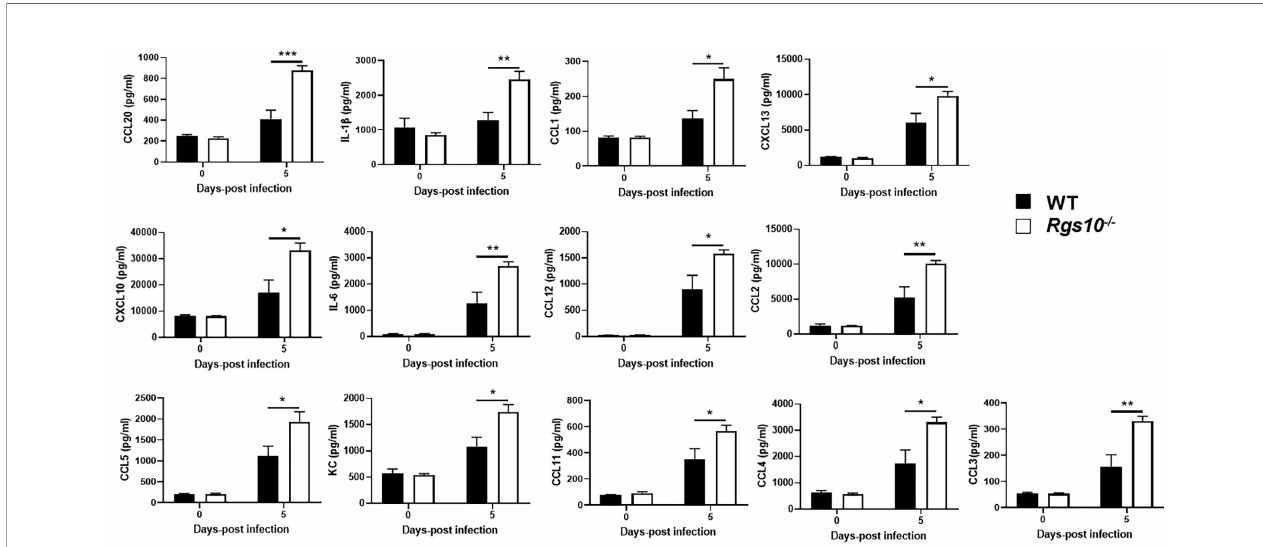
FIGURE 4 | Rgs10 de fi ciency elevates cytokine and chemokine levels upon IAV infection. The bead-based Bio-Plex assay was used to measure cytokine and chemokine levels in the BALF supernatants of uninfected (0 dpi) WT and Rgs10-/- mice (n=5) or WT and Rgs10-/- mice (n = 7) infected intranasally with 100 PFU of PR8 virus at 5 dpi. Data were analyzed for statistical differences using an analysis of variance (ANOVA) followed by Tukey post hoc test between groups. Data are presented as mean ± SEM where *p < 0.05; **p < 0.01; ***p < 0.001.